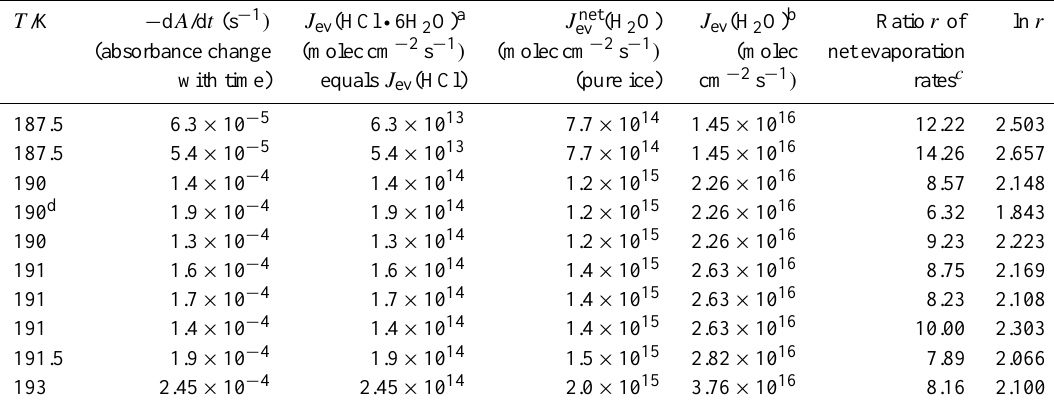
Table 5. Rate of decrease of absorbance upon evaporation of a HCl ration rates for pure ice together with evaporation rates for ice and HCl hexahydrate. T /K